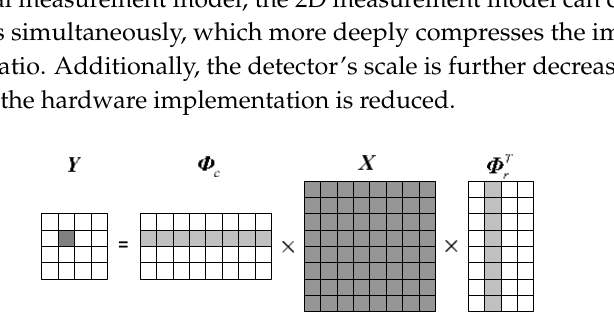
Figure 1. Two-dimensional (2D) measurement model graph: Y is the compressive sampling signal, Φ c and Φ r are measurement matrixes, X is the two-dimensional original signal.